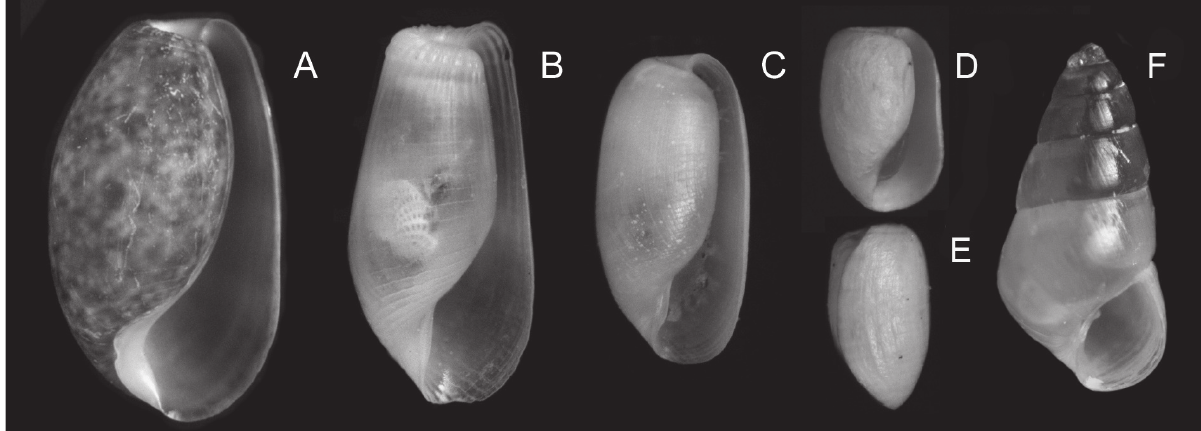
Fig . 4. – opistobranch and Pyramidellid gastropods of Zostera marina . a, apertural view of Bulla striata (shell height: 12 mm); B, apertural view of Pyrunculus hoernesii (2.2 mm), with a benthic foraminifer visible by transparency; C, apertural view of Cylichnina crossei (1.8 mm); d, e, apertural and lateral view of Retusa minutissima (0.9 mm); f, apertural view of Odostomia turrita (1.7 mm).